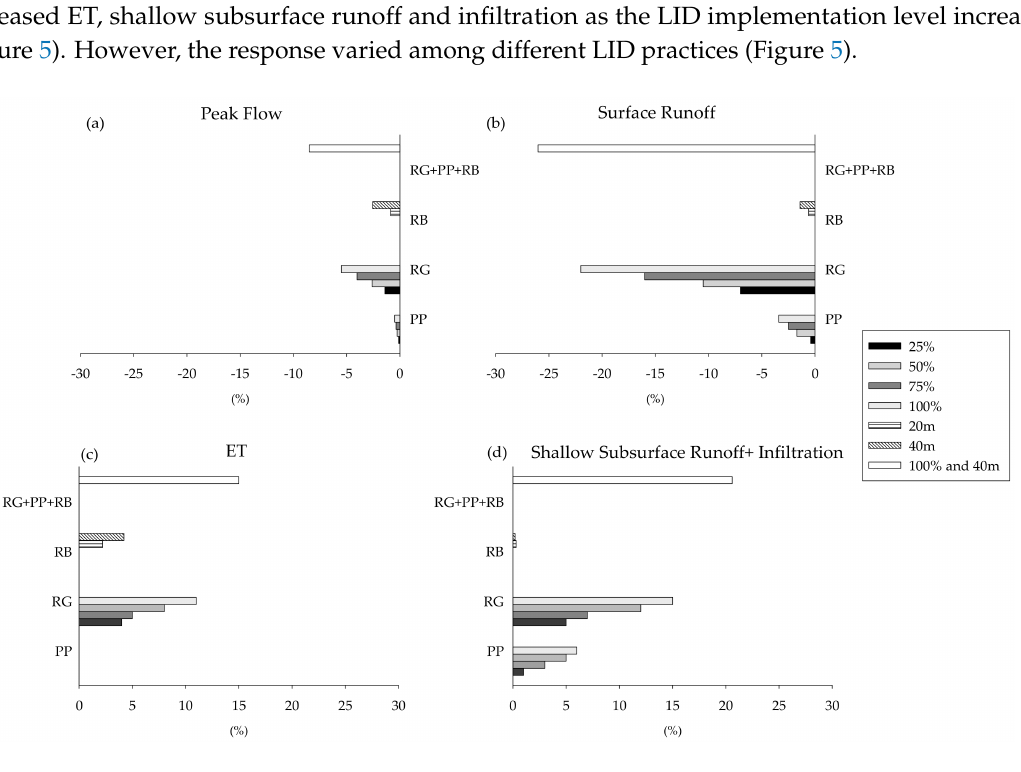
Figure 5. Percent change for watershed water balance components for three different types of LID practices at the outlet of the watershed (RG: Rain Garden, PP: Permeable Pavement, and RB: Riparian Buffer), ( a ) peak flow; ( b ) surface runoff; ( c ) ET (evapotranspiration); and ( d ) shallow subsurface runoff and infiltration. At the maximum level of implementation (100% and 40 m) RG, PP, and RB cover 6.4%, 2.1%, and 3% of the total watershed area,